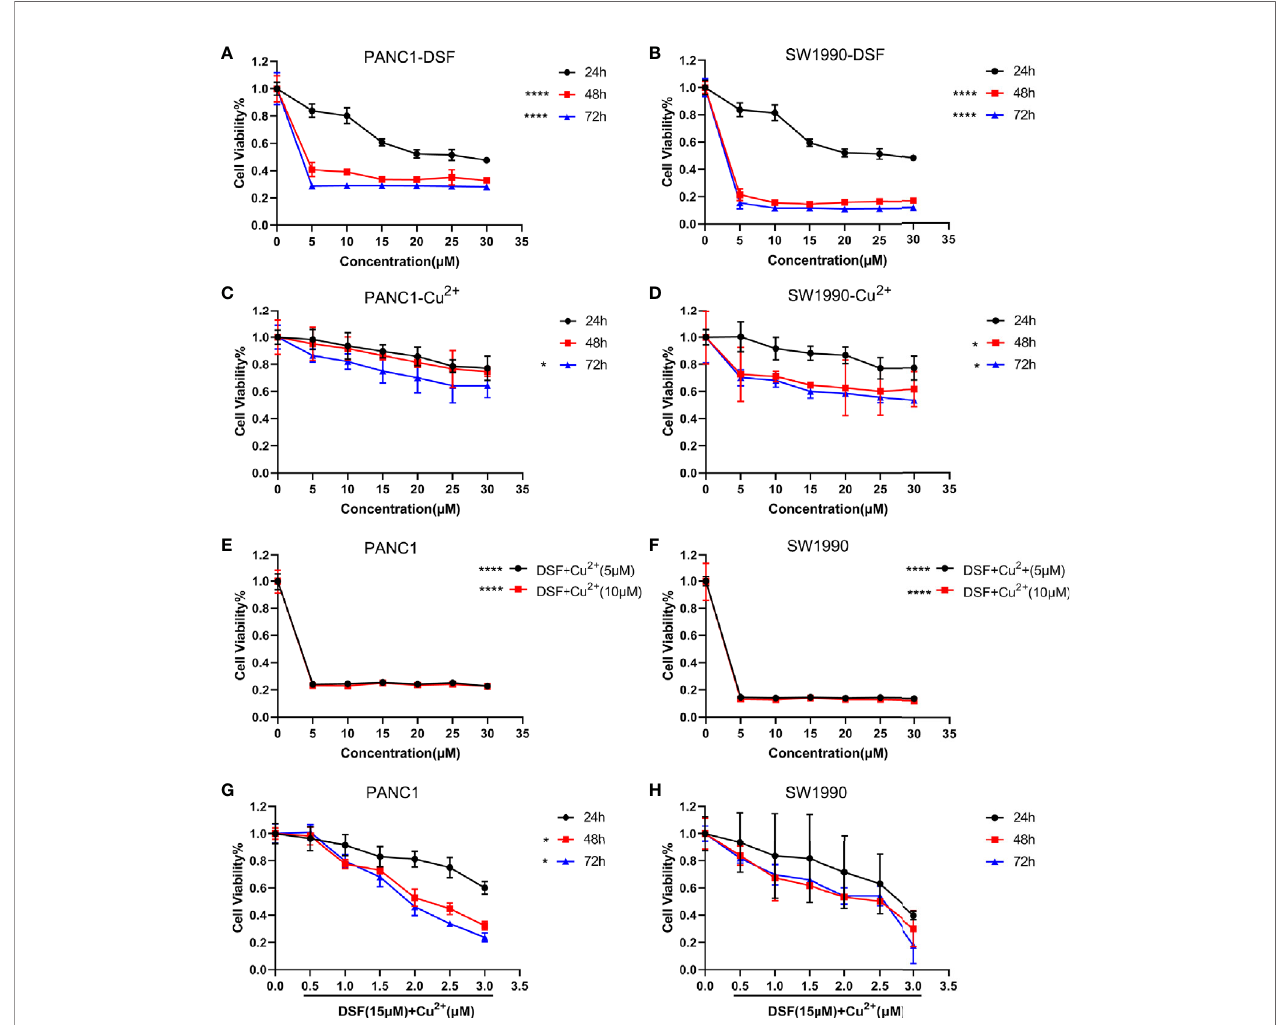
FIGURE 1 | DSF inhibits cell proliferation in a dose- and time-dependent manner. A CCK-8 cell viability assay was conducted to determine the effects of DSF alone or the DSF/Cu 2+ complex on proliferation of the pancreatic cancer cell lines PANC-1 and SW1990. First, cells were incubated with DSF at different concentrations (0 – 30 m M) (A, B) , 0 – 30 m M Cu 2+ for 24 h, 48 h and 72 h (C, D) , *p < 0.05, ****p < 0.0001, compared with 24 h. Moreover, cells were cultured with 0 – 30 m M DSF combined with 5 m M or 10 m M Cu 2+ for 24 h (E, F) , ****p < 0.0001, compared with control, or incubated with 15 m M DSF combined with various concentrations of Cu 2+ for 24 h, 48 h and 72 h (G, H) , *p < 0.05, compared with 24 h. Then, the cells were incubated with CCK-8 solution for 1 h at 37°C, and the absorbance was detected at 450 nm using a microplate reader. The percentage of viability was computed by the following formula: viability=treated cell absorbance/ untreated cell absorbance×100. Data were obtained from 3 independent experiments, and statistical analyses were performed using one-way ANOVA.